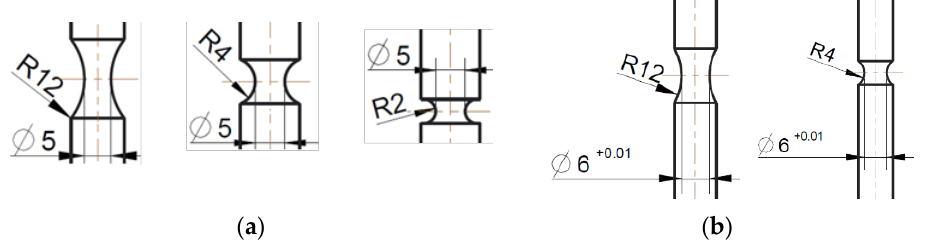
Figure 3. Notched round tensile specimens of ( a ) the BM and ( b ) the